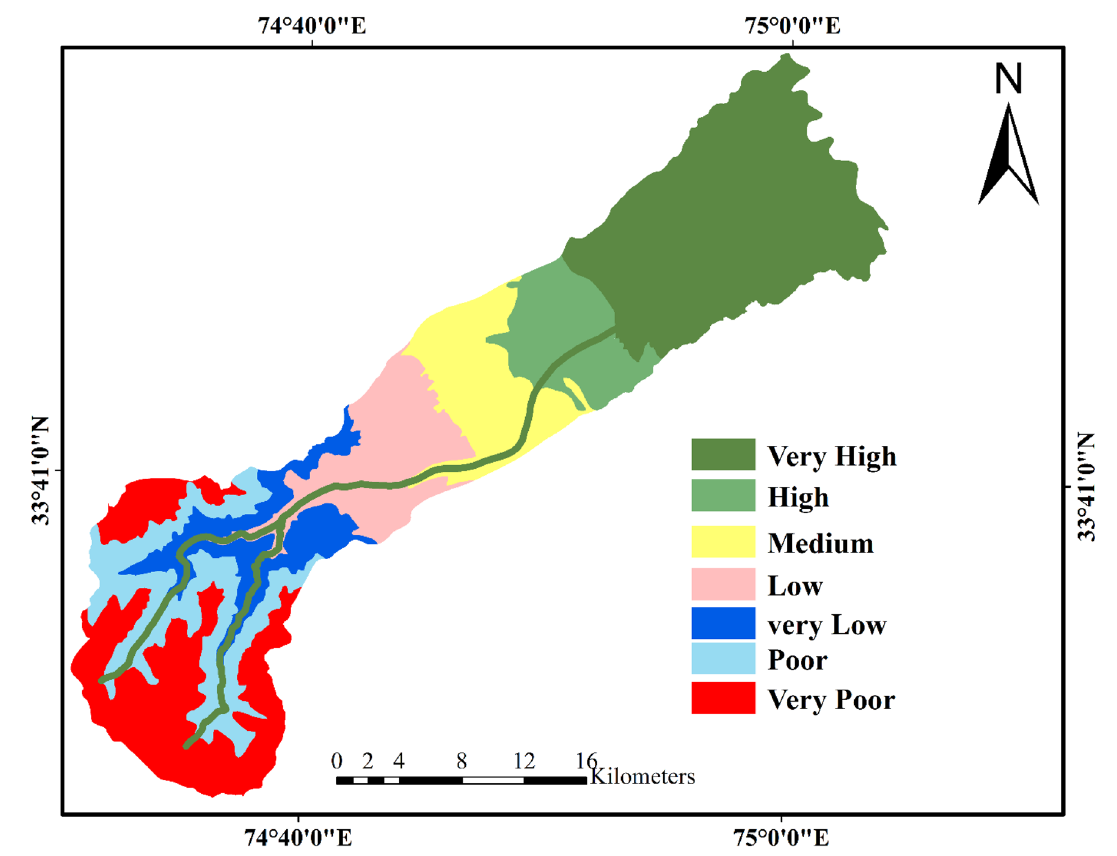
Fig. 9 Groundwater potential map of the Rambiara river